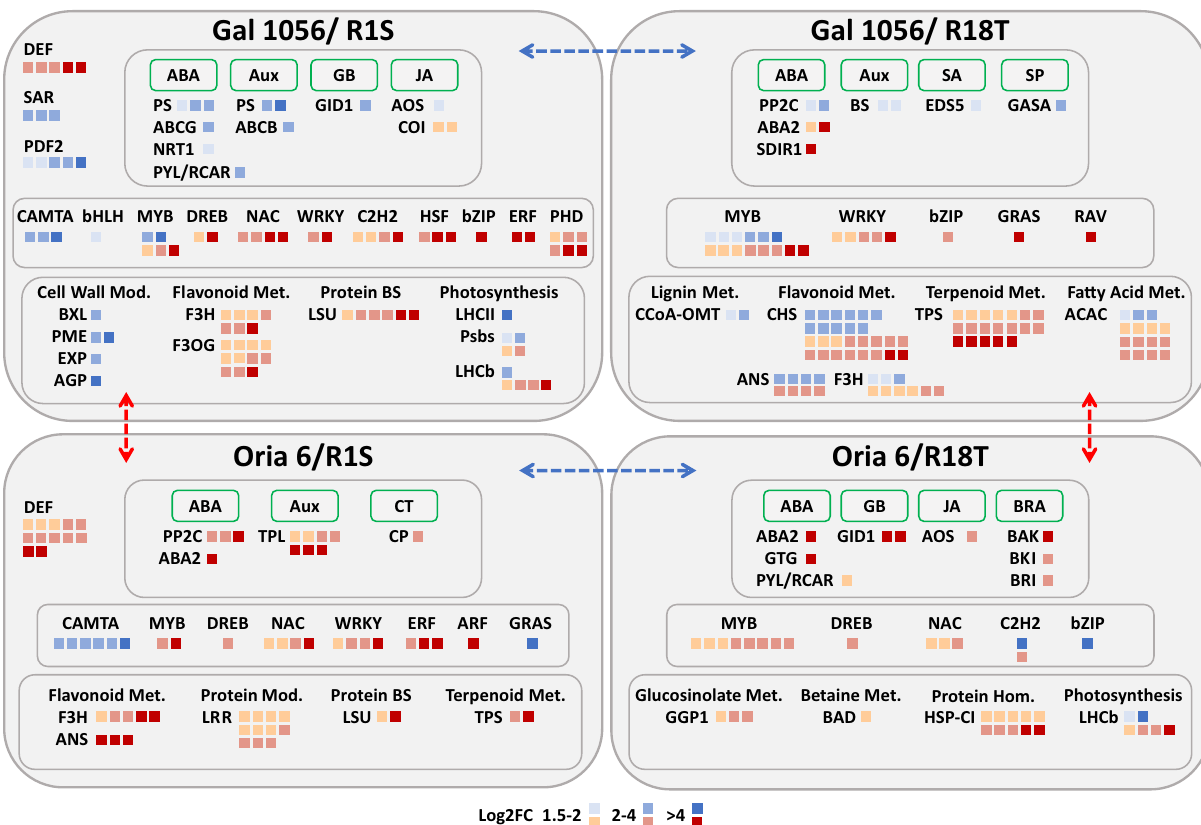
Protein Hom. Photosynthesis Protein BS Terpenoid Met.